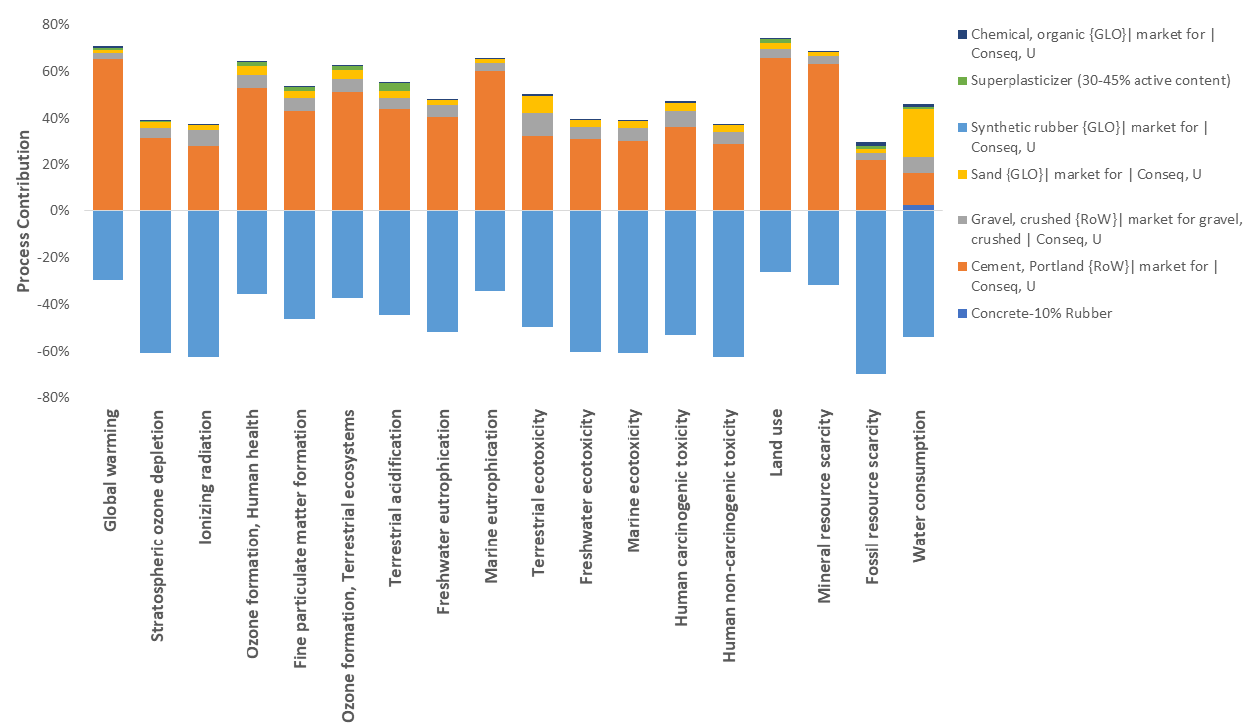
Figure 10. Process contribution for the 10% recycled rubber dosage.